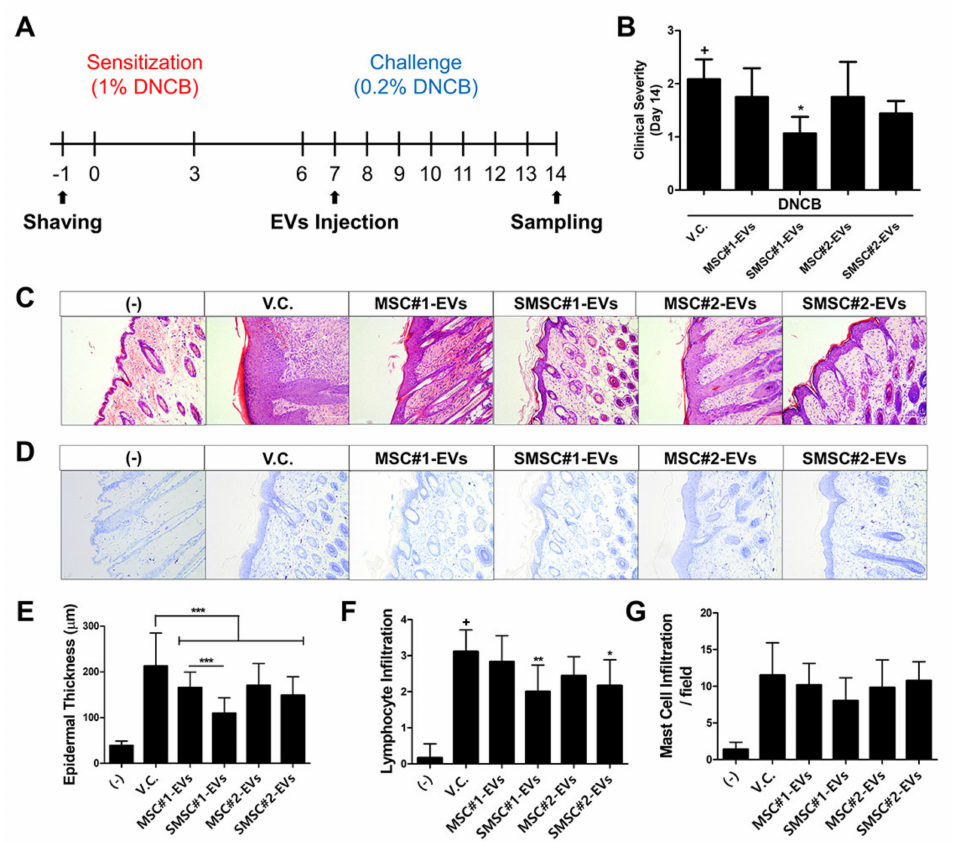
Figure 8. Therapeutic e ffi cacy of EVs derived from SOD3-MSCs in AD mice. ( A ) MSC-derived EVs were subcutaneously administrated into DNCB-induced AD mice on day 7. ( B ) On day 14, clinical severity was scored ( C ) H&E staining and ( D ) toluidine blue staining of skin tissue sections. ( E ) Epidermal thickness, ( F ) lymphocyte infiltration, and ( G ) mast cell infiltration were measured. Scale bar = 100 µ m. Results are shown as mean ± SD. *, ** and *** represent p < 0.05, p < 0.01 and p < 0.001, respectively. p -value significance was calculated by comparing other groups against the ( + ) group (marked as +